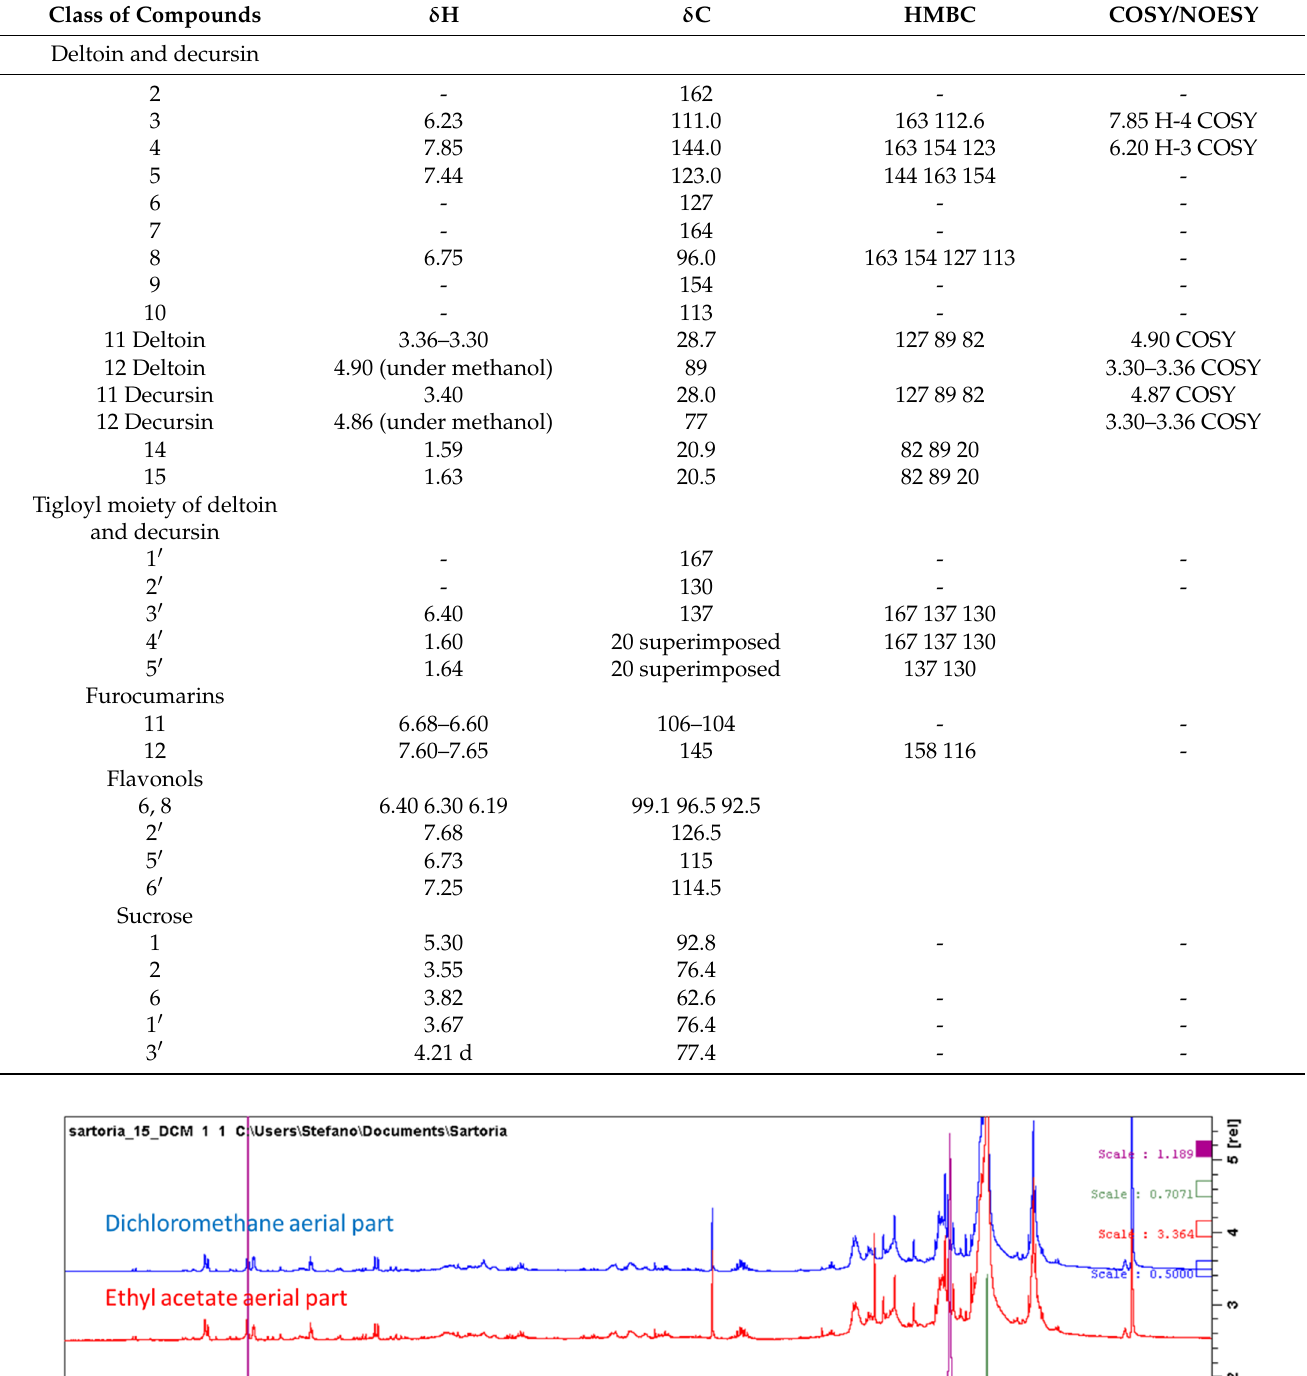
Table 2. NMR assignments of the main constituents detected in the methanol extract of S. hedysaroides aerial part.